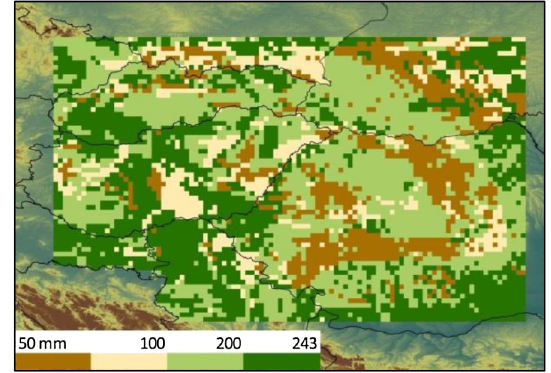
Figure 2. Available water holding capacity (AWC) of the soil (mm) in the Carpathian